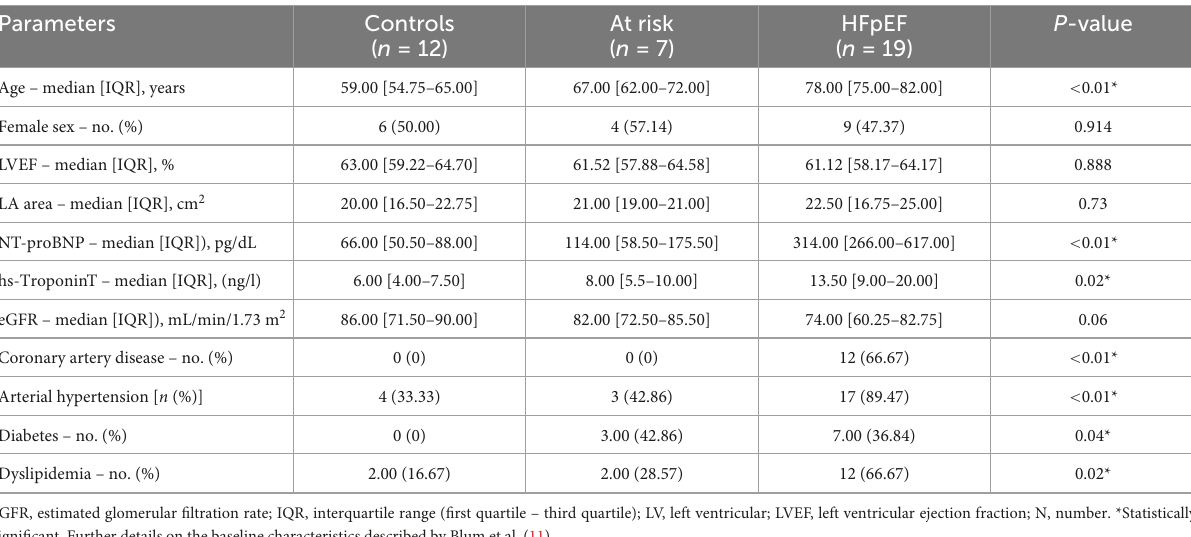
TABLE 1 Baseline characteristics.